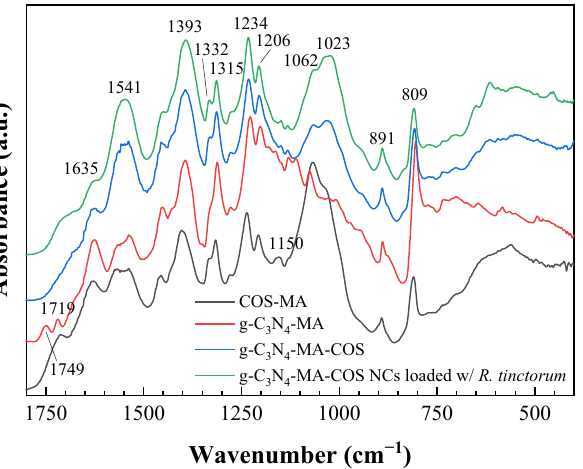
Figure 1. Fingerprint region of the infrared spectra of methacrylated chitosan oligomers (COS-MA), methacrylated graphitic carbon nitride (g-C 3 N 4 -MA), g-C 3 N 4 -MA-COS nanocarriers, and g-C 3 N 4 - MA-COS nanocarriers loaded with R. tinctorum extract.